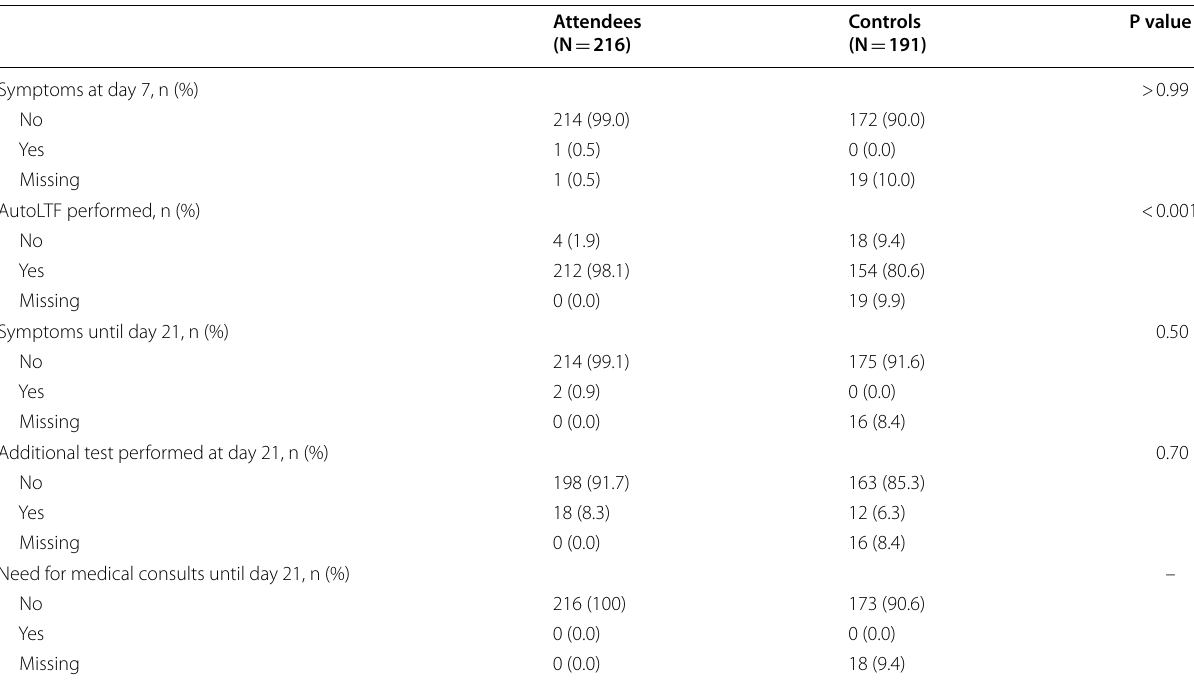
200, 16 patients with missing value). b Controls(n =